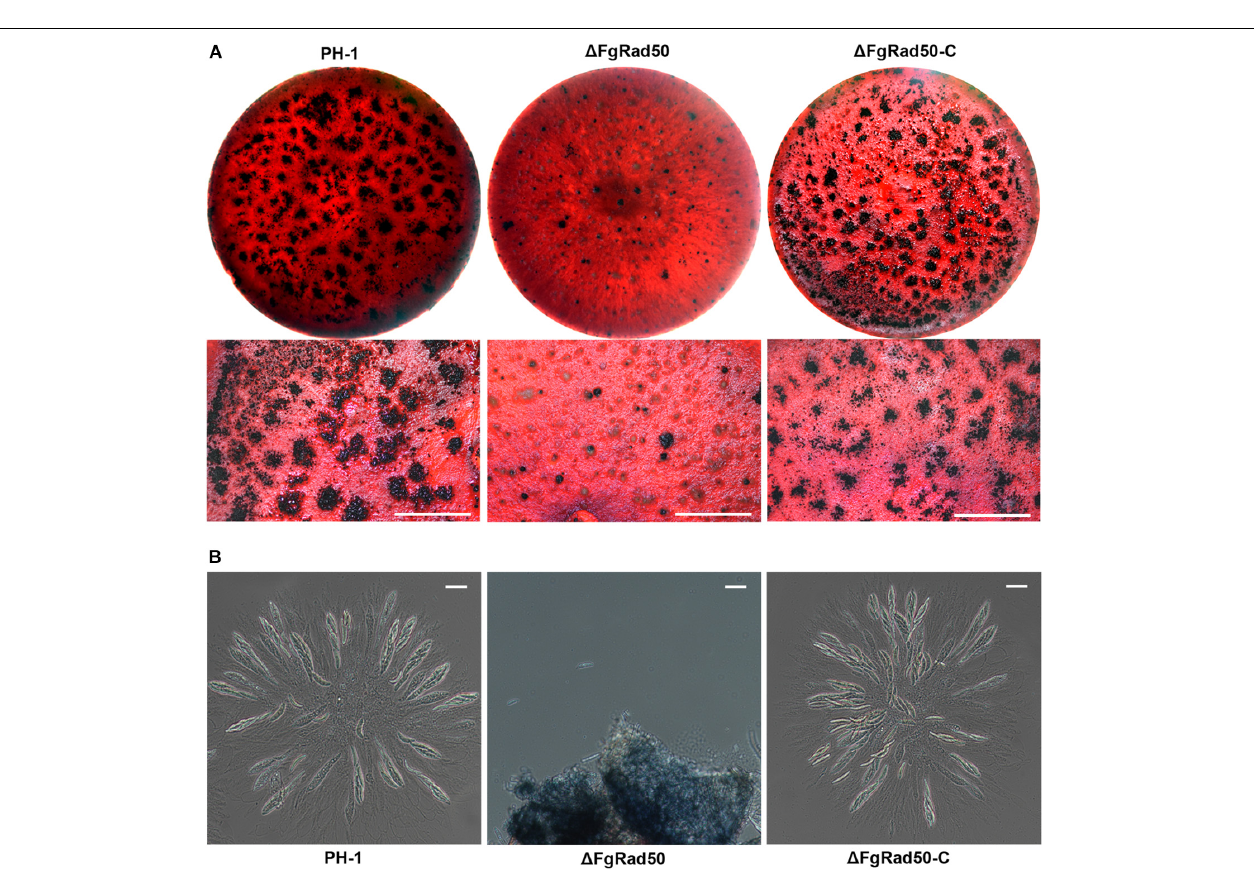
FIGURE 3 | Analysis of defective sexual reproduction in the (cid:49) FgRad50 mutant. (A) Perithecium formation in mating cultures of PH-1, (cid:49) FgRad50 and (cid:49) FgRad50-C examined at 3 weeks post-induction. Bar = 1 mm. (B) Dissection of perithecia showing asci and ascospores of WT PH-1, (cid:49) FgRad50 and (cid:49) FgRad50-C. Scale bar = 20 µ